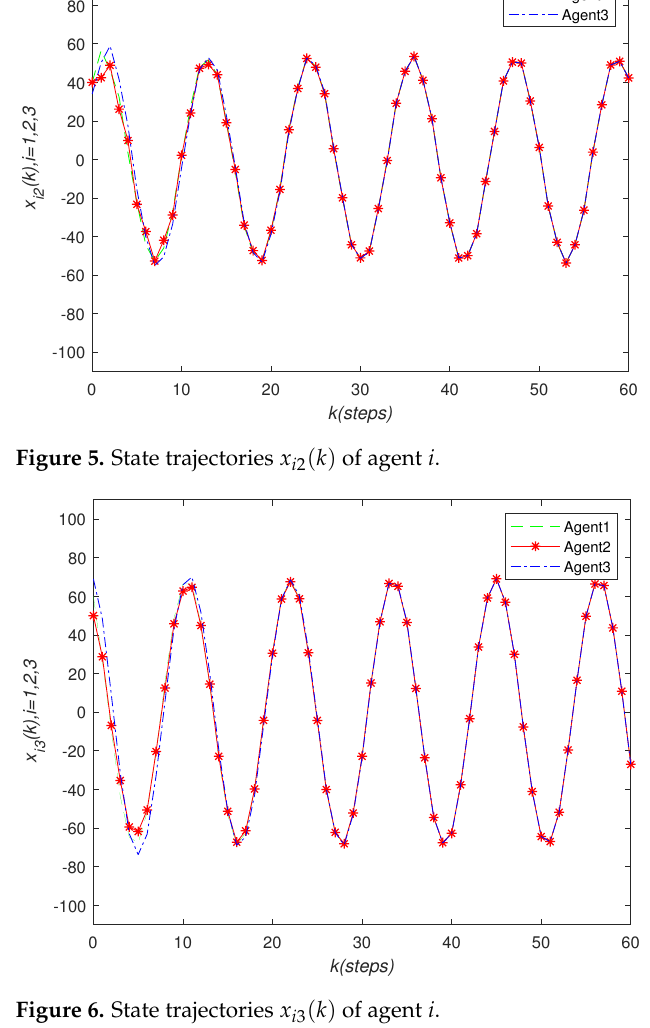
Figure 6. State trajectories x i 3 ( k ) of agent i .